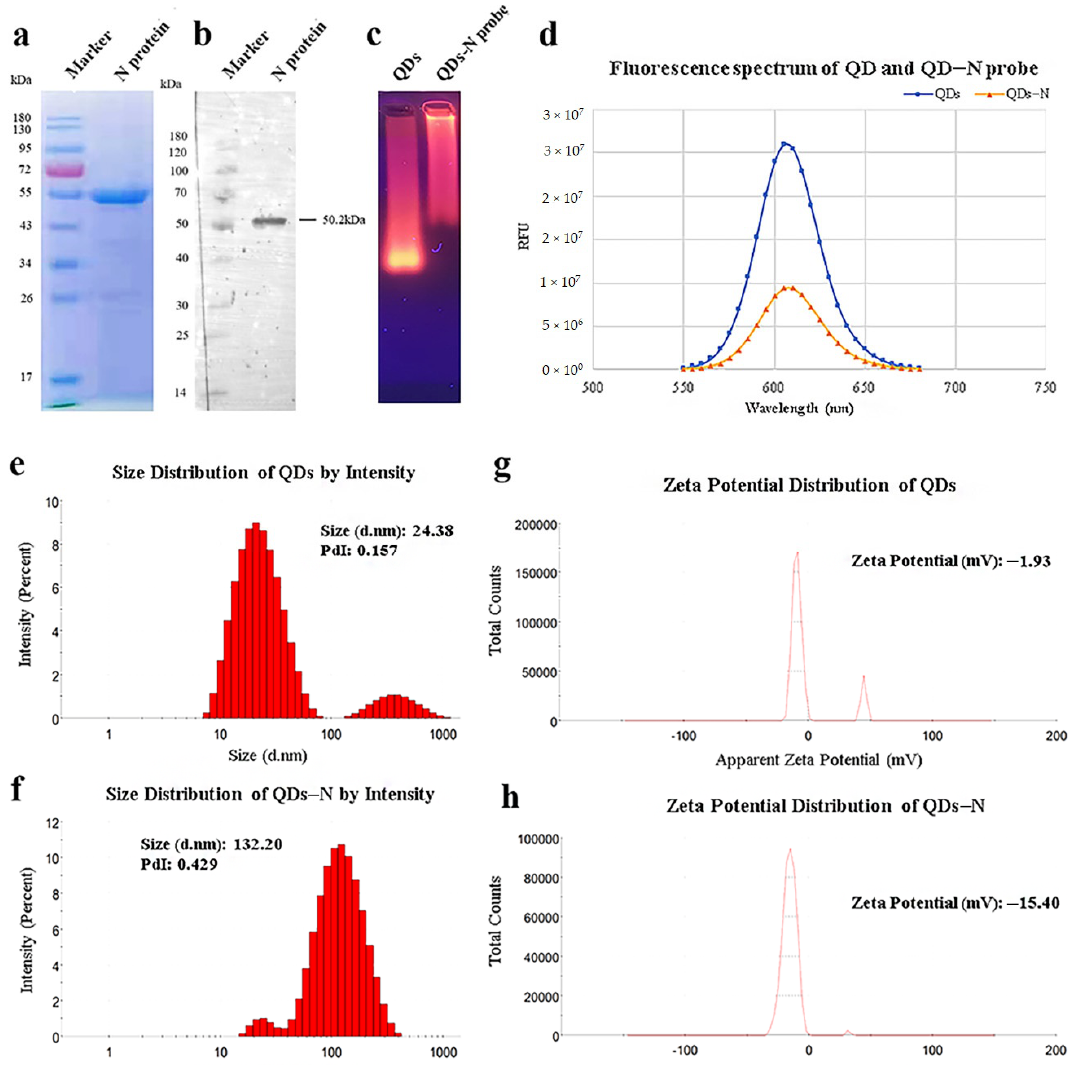
Figure 1. Identification of purified nucleocapsid protein and QDs-conjugated N protein. ( a ) Purified nucleocapsid protein isolated by 12% SDS-PAGE. ( b ) Purified nucleocapsid protein isolated by Western blot. Lane 1: Protein Ladder. Lane 2: N protein reacted with anti-His-Tag mouse monoclonal antibody (5C3). ( c ) QDs and conjugates identified by agarose gel electrophoresis. ( d ) Fluorescence spectrum of QDs and conjugates. ( e – h ) Size distribution and ζ potential distribution of QDs and conjugates, as measured by Malvern Zetasizer.